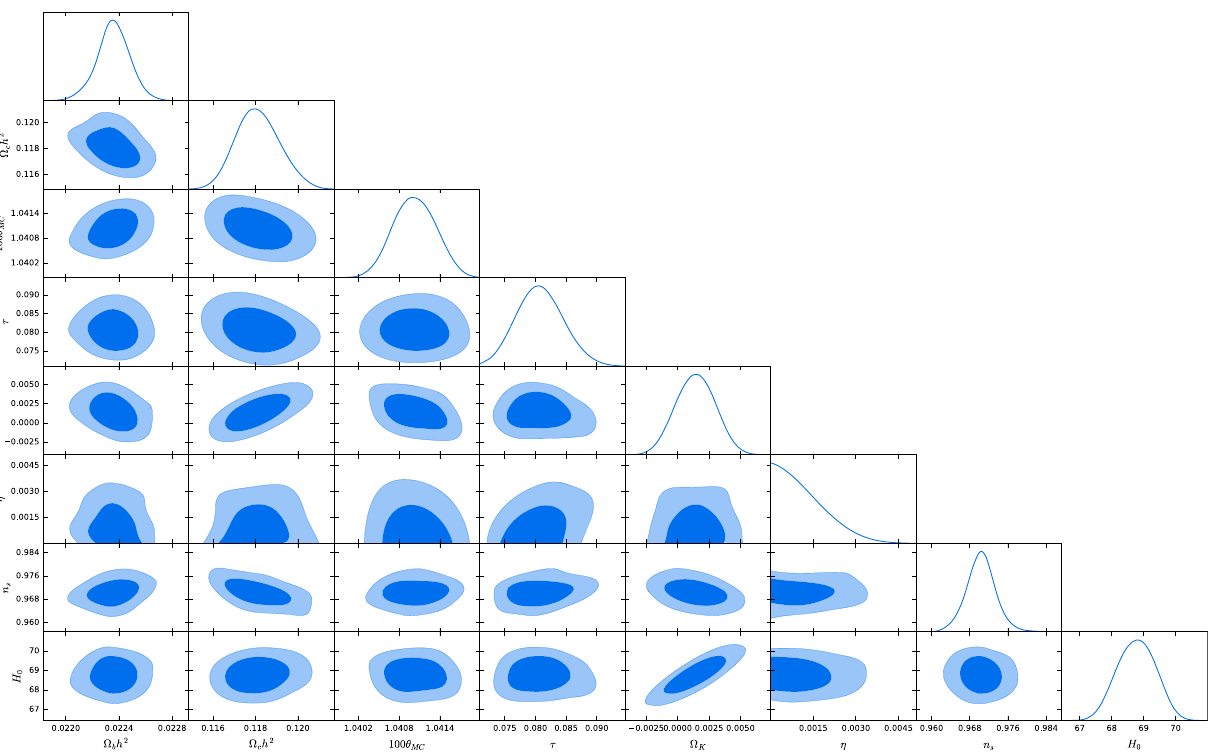
Fig. 7 The 1-dimensional posterior distributions on the individual parameters and 2-dimensional marginalized contours of the V ω DE model using the data combination